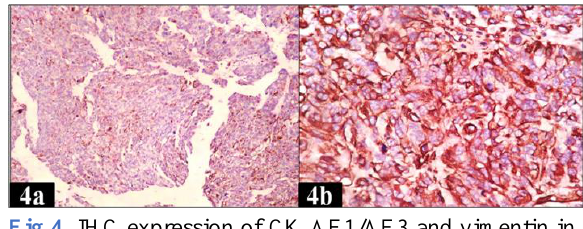
Fig 7. IHC expression of CK AE1/AE3 and vimentin in malignant mucinous tumor of ovary (a)Strong membranous staining of CK (400X) (b) No immunostaining of vimentin